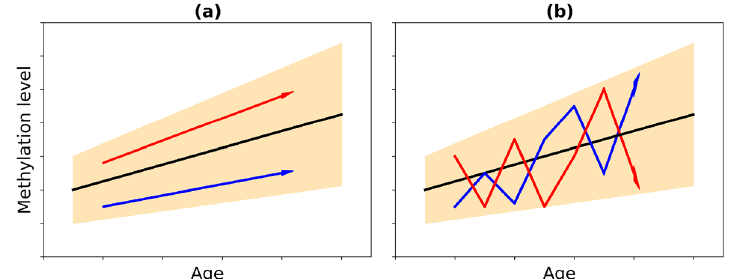
Figure 1. Illustration of possible mechanisms behind increasing variability with age: ( a ) deterministic divergence due to heterogeneity between individuals and ( b ) due to